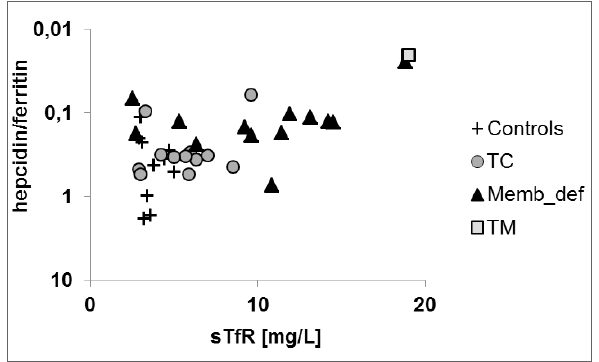
Fig. 2. Differentiation of patients based on the plot of hepcidin/ ferritin ratio against sTfR 15 . Patients with erythrocyte membrane defect (Memb_def, n=13), thalassemia carriers (TC, n=12) and thalassemia major (TM, n=1) dislocate from healthy controls